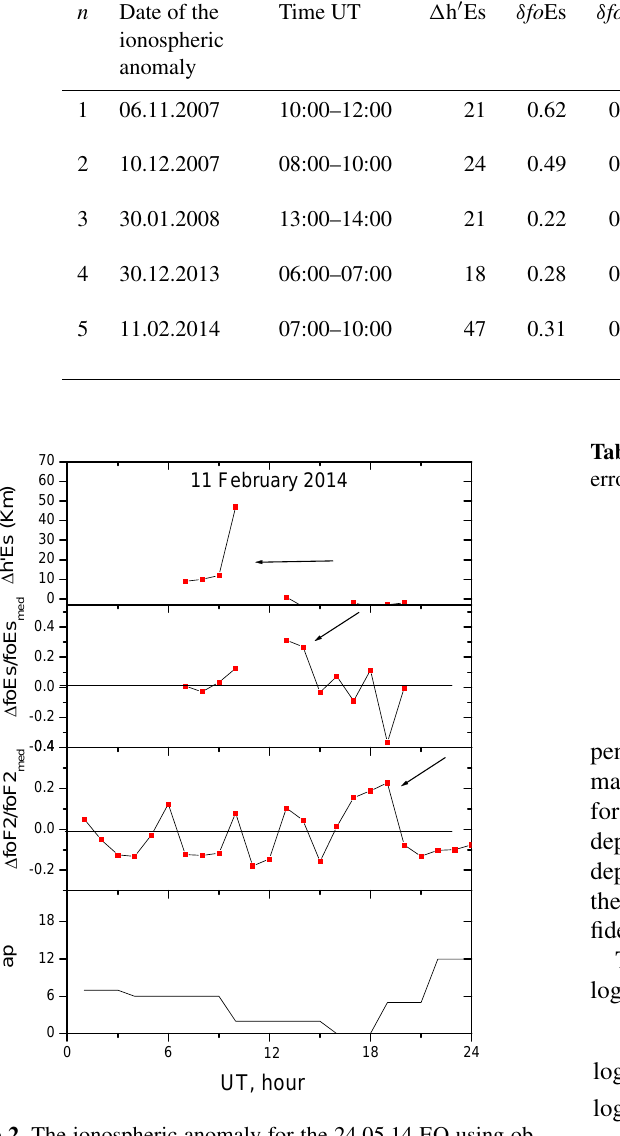
Figure 2. The ionospheric anomaly for the 24.05.14 EQ using ob- served (cid:49) h (cid:48) Es, δ fo Es and δ fo F2 variations (arrows). Three-hour a p indices are given in lower panel.